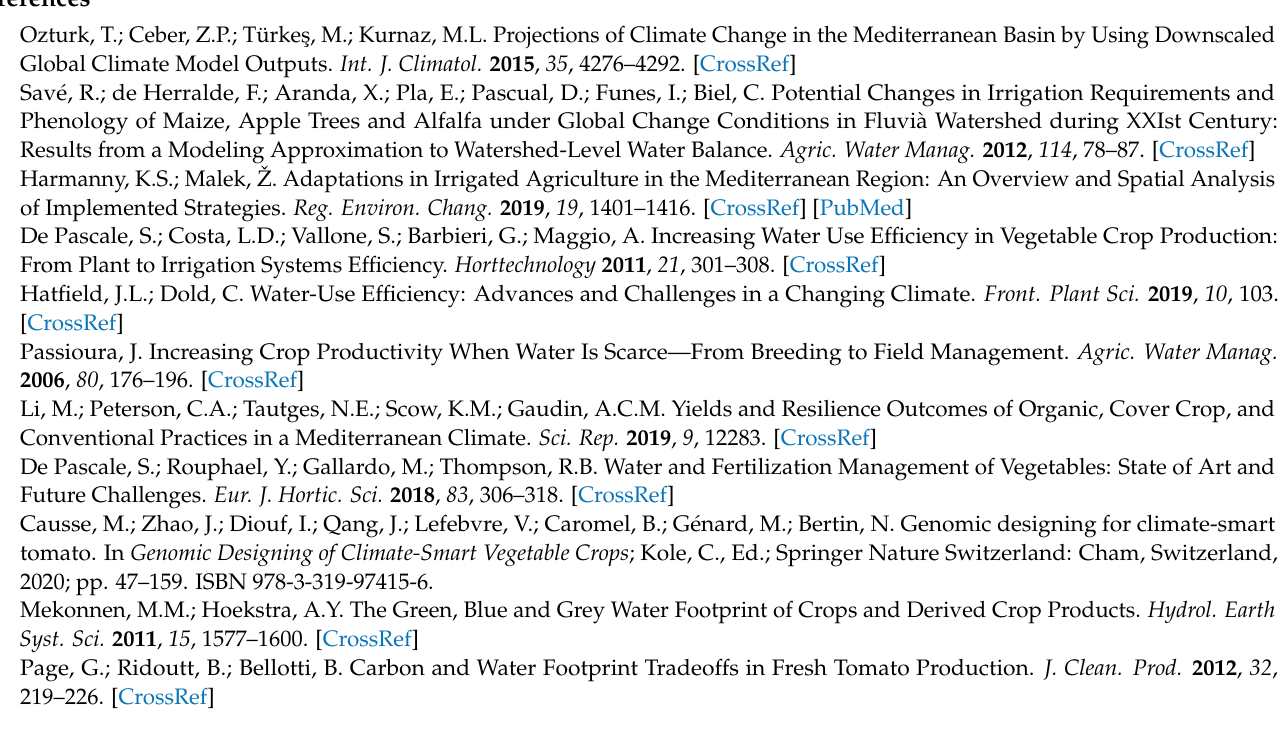
Table S4: Effect of irrigation regime (I), genotype (G) and locality (L) on fruit quality traits; Table S5: Effect of irrigation regime (I), genotype (G) and locality (L) on postharvest shelf life (% sound fruits) during extended storage of the fruits (30, 60, and 90 days) under laboratory conditions (24 ± 2 ◦ C; 62 ± 11% relative